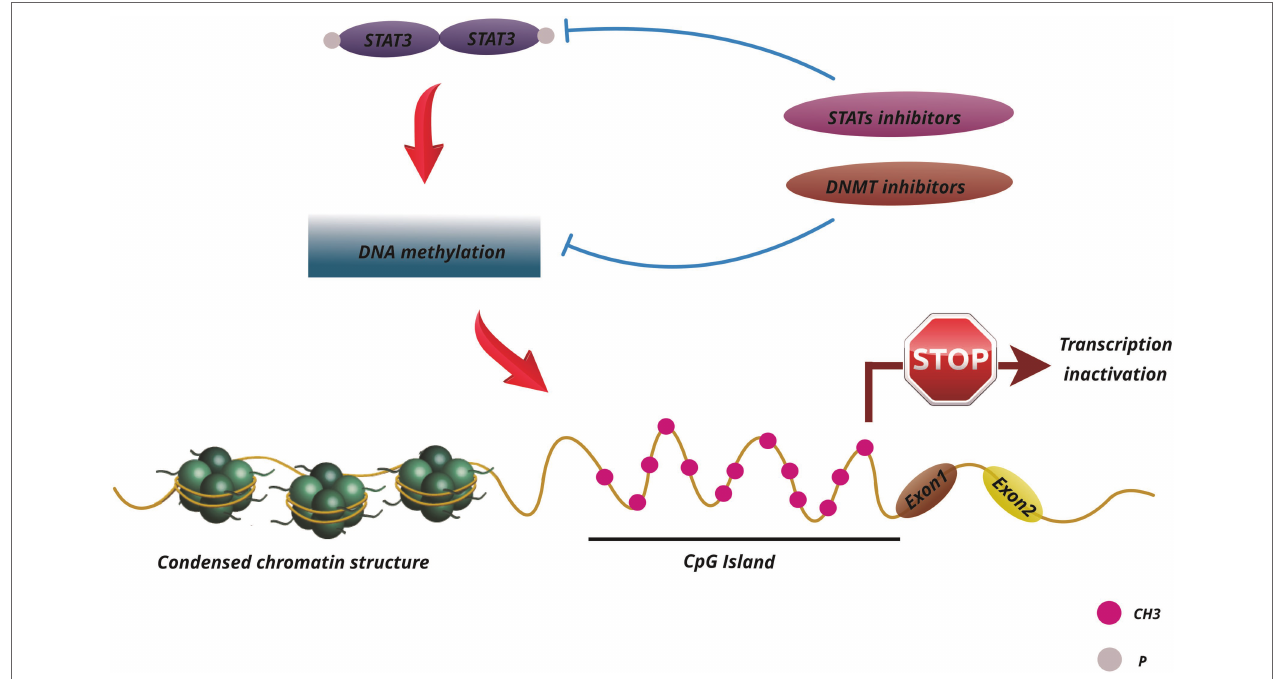
FIGURE 4 | Scheme of STAT3 function and epigenetic changes in cancers and current pharmaceutical drugs that target epigenetic mechanisms (DNMT1) and STAT signaling pathway